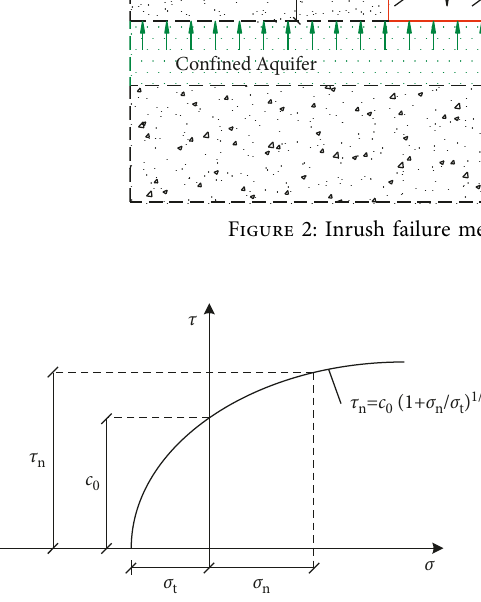
Figure 3: Nonlinear Mohr–Coulomb failure criterion.